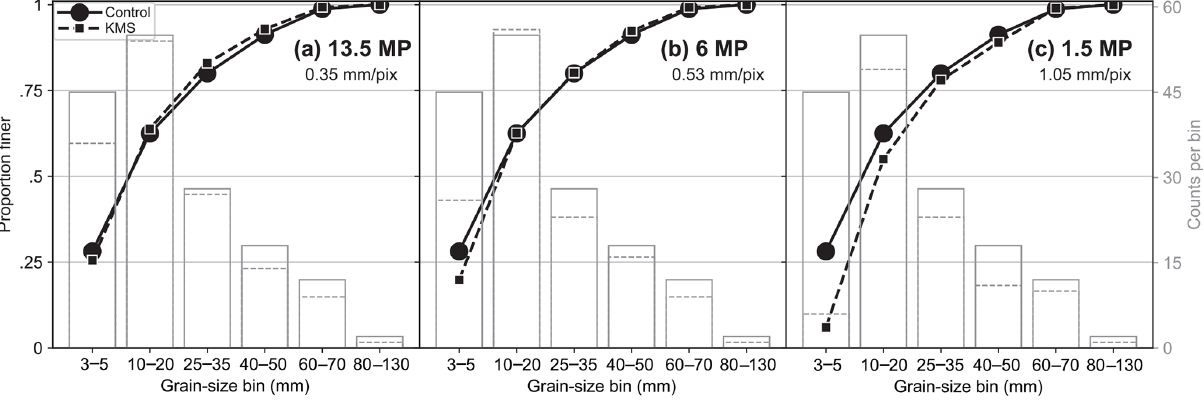
Figure 5. Results of reducing the image dimensions to (a) 75% (13.5 megapixels), (b) 50% (6 megapixels), and (c) 25% (1.5 megapixels) and rerunning the KMS approach on the distribution in Fig. 4a. The control is shown as solid black (left y axis) and gray (right y axis) lines and KMS as the dashed